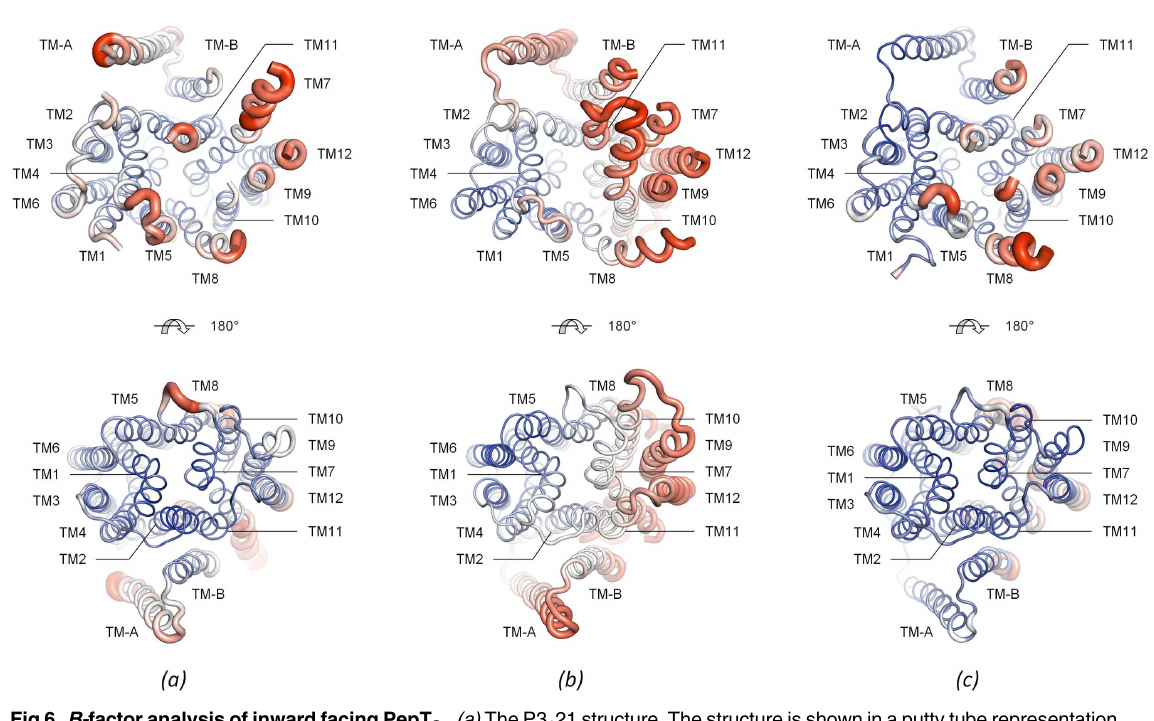
Fig 6. B- factor analysis of inward facing PepT St . (a) The P3 1 21 structure. The structure is shown in a putty tube representation where the diameterof the tube is correlatedwith the magnitudeof the C-alpha B- factors. The structure is furthermore also colored by C-alpha B- factors: colors are rampedfrom blue over white to red, with blue designating low values and red designatinghighvalues. Two views are shown: cytoplasmic(top) and periplasmic(bottom). (b) The P2 1 2 1 2 1 structure (PDB: 4APS) depictedas in panel a . (c) The C222 1 structure (PDB: 4D2C) depictedas in panel a . A similar B- factor analysison PepTs from other organisms is provided in S2 Fig. Higher B- factors are an indicationof higherflexibility, but it shouldbe noted that the regions with highest flexibility are those that could not be modeledat all, for examplelobe TM10–TM11 in the C222 1 and P3 1 21 structures, and the cytoplasmictip of TM7 in the P2 1 2 1 2 1 and C222 1